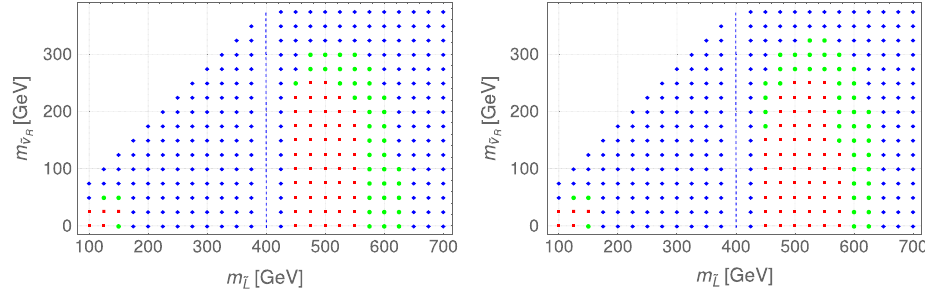
and m ˜ due to slepton/sneutrino production in the case of an R-sneutrino LSP with M 1 = M 2 = 2 TeV L R + 25 GeV and tan β = 6. Color conventions follow Fig. 4 R